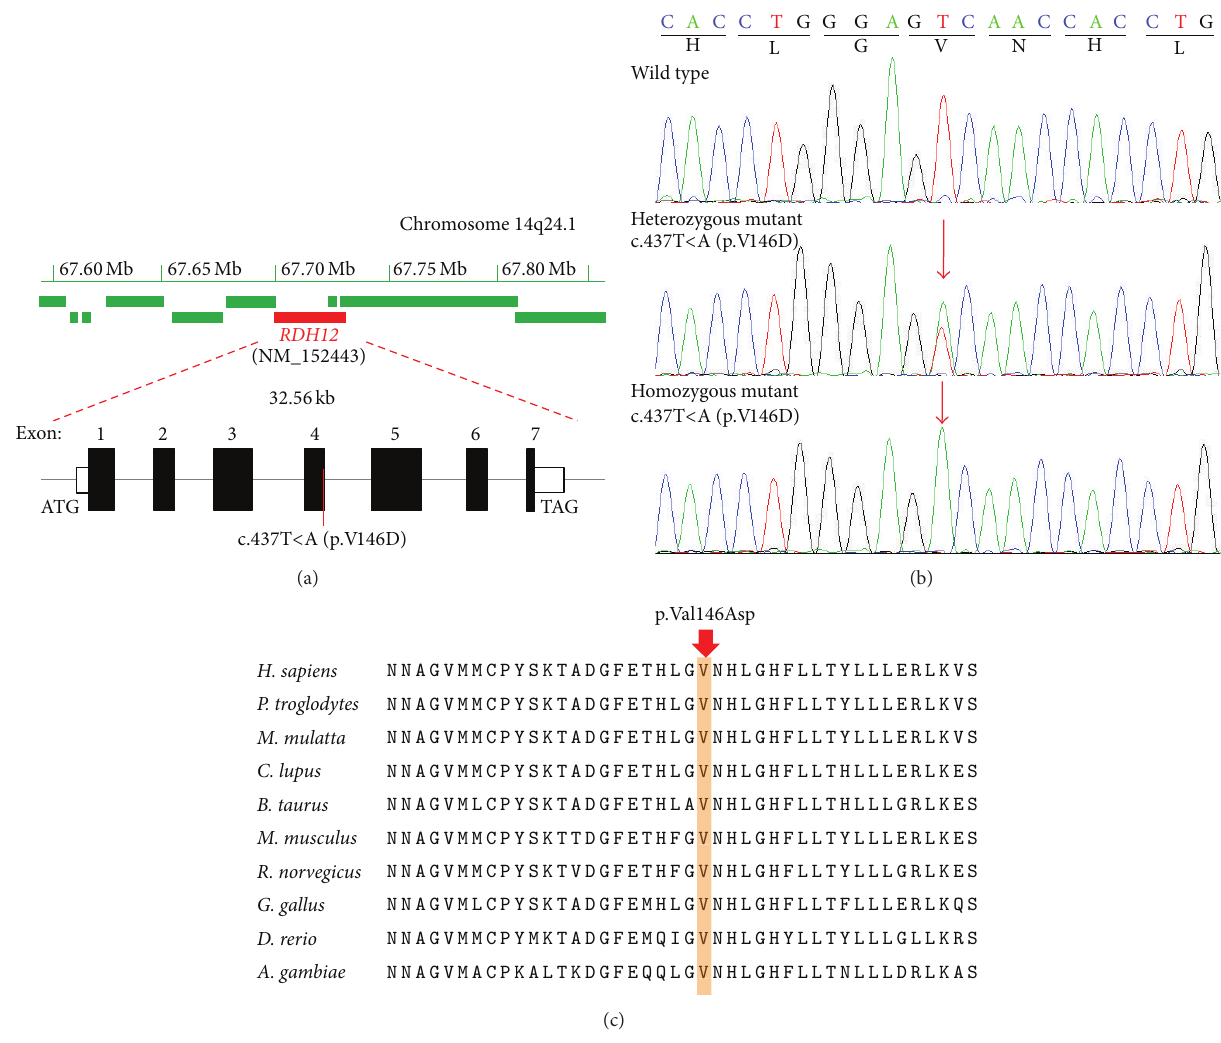
Figure 3: Representative chromatogram of RDH12 sequence. (a) The RDH12 gene (red filled box) spanning 32.56 kb on chromosome 14q24.1 (upper panel) contains 7 exons. The identified homozygous variant, c.437T < A (p.V146D), was located in exon 4 of this gene; (b) normal sequence from an unaffected member (I: 1), a heterozygous T to A substitution at codon 146 from unaffected member (I: 2, I: 4, II: 2), and a homozygous change from (III: 1 and III: 2). (c) Orthologous protein sequence alignment of RDH12 from different species; the mutated residue showing conservation of Valine (V) at codon 146 was shaded in